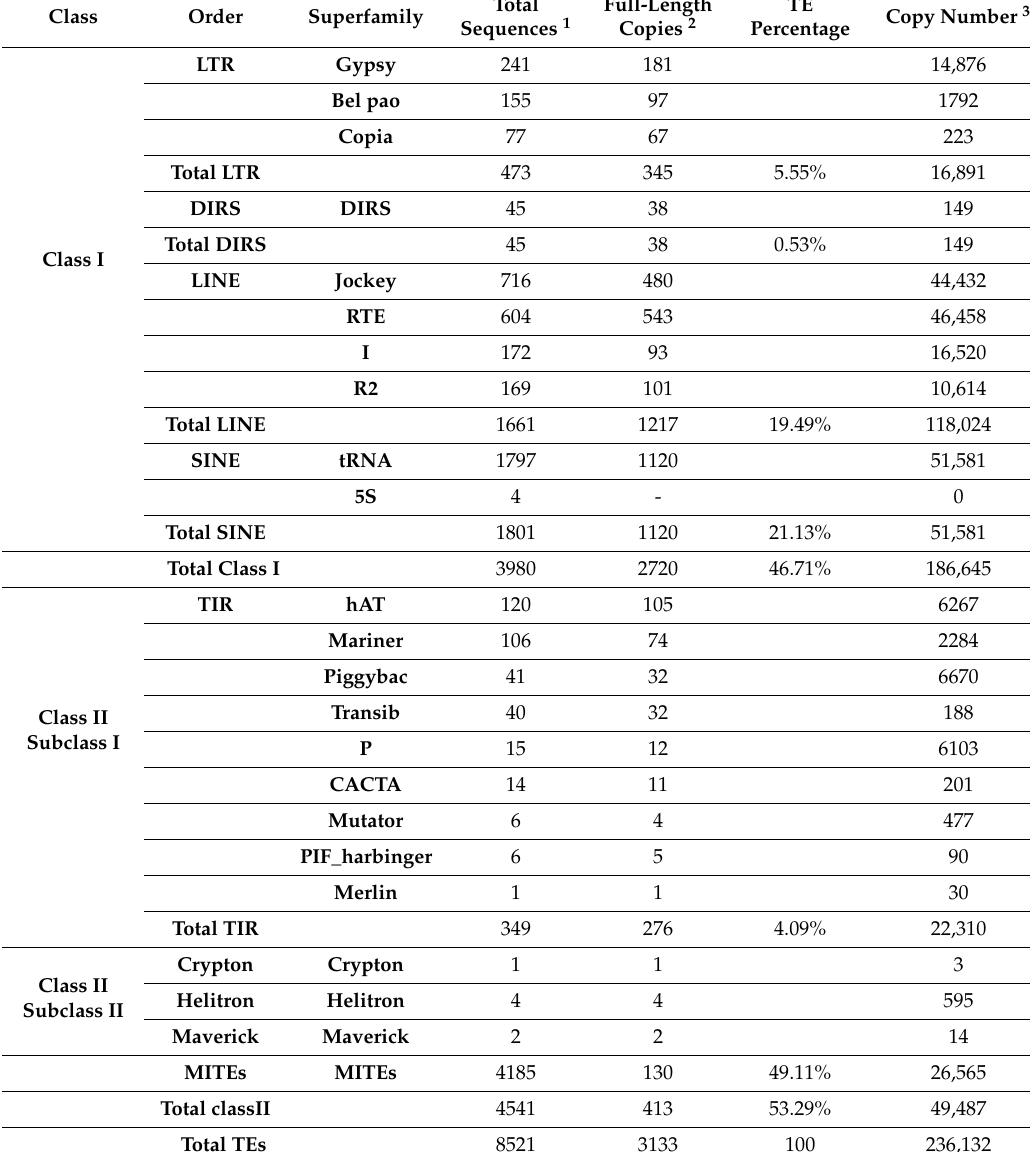
Table 1. Summary of the identified and annotated TEs in the H. armigera